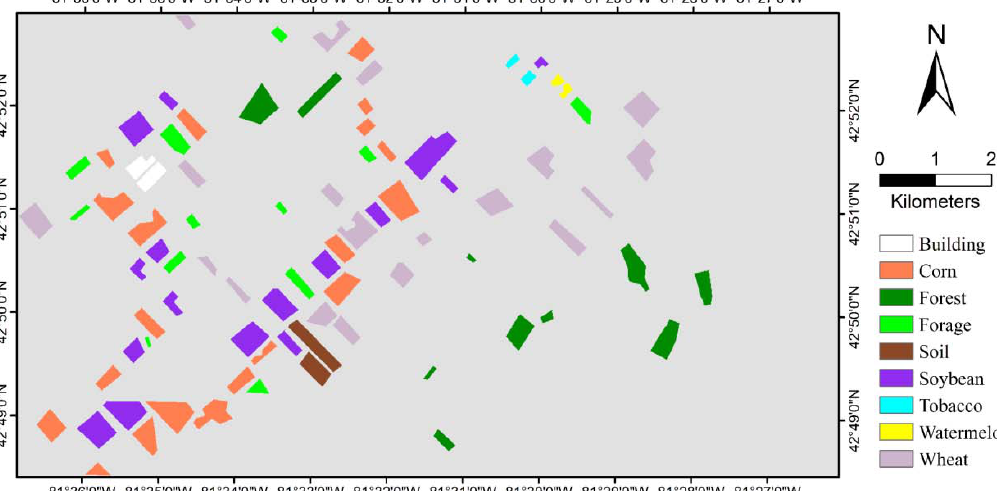
Figure 2. Map of identified land ‐ cover types. Table 2. The collected field data and the number of pixels for classification training and testing.